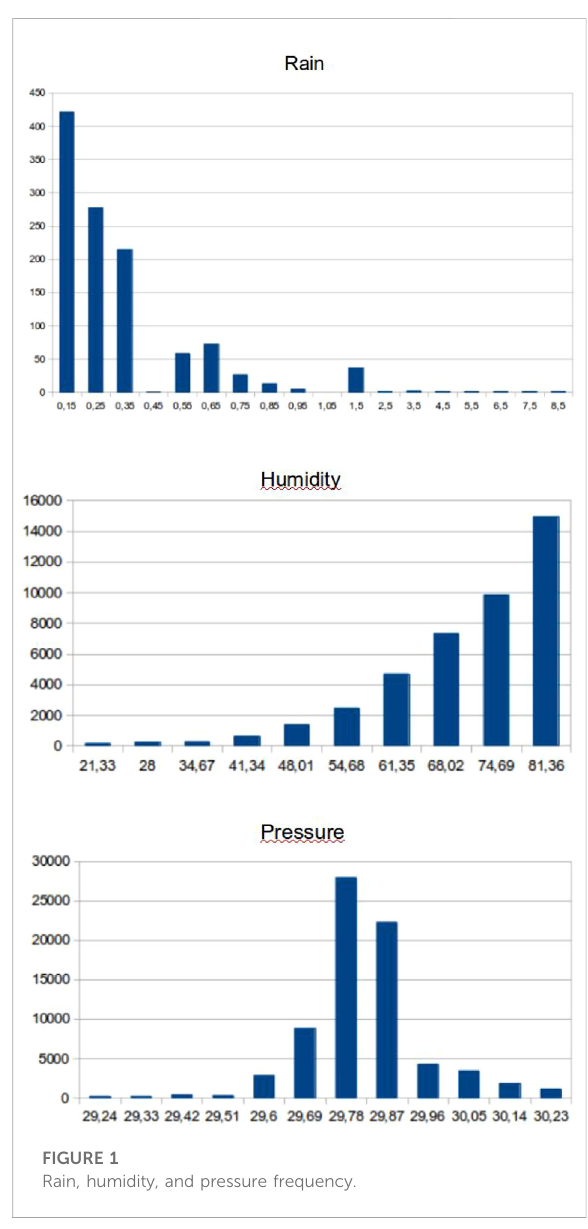
FIGURE 1 Rain, humidity, and pressure